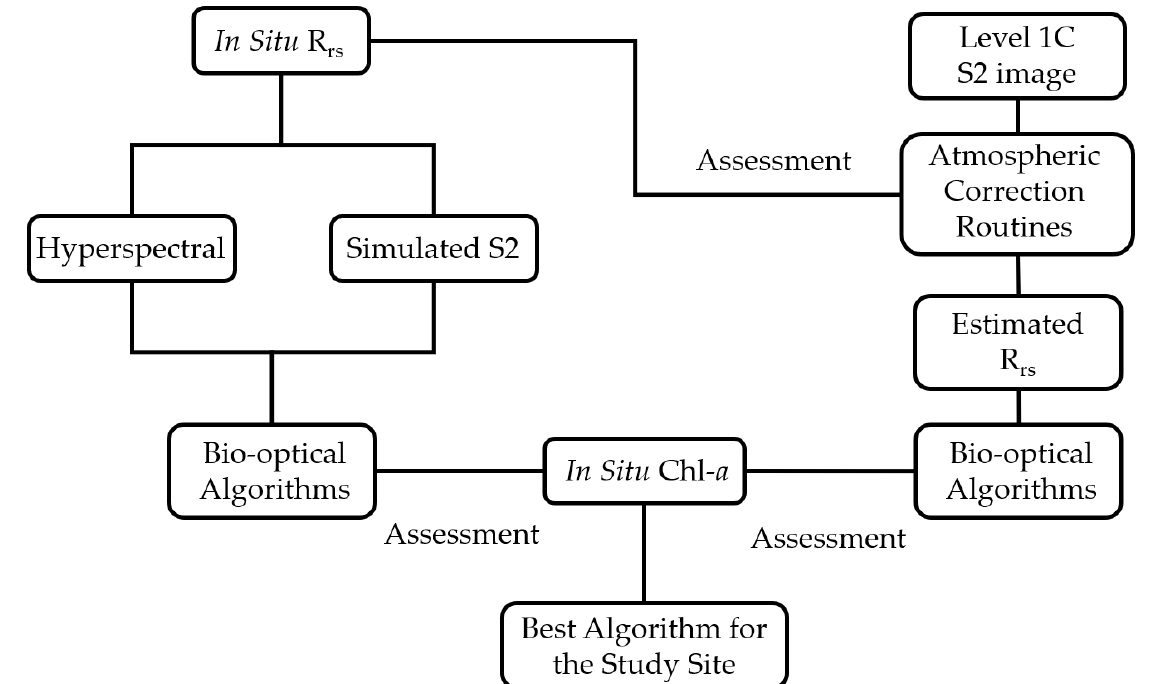
Figure 2. Flowchart of the main steps in this Figure 2. F lowchart of the main steps in this study.